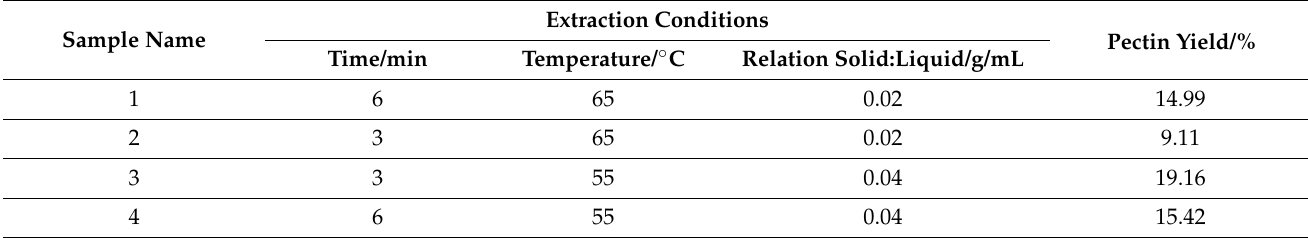
Table 1. Experimental design and yield of